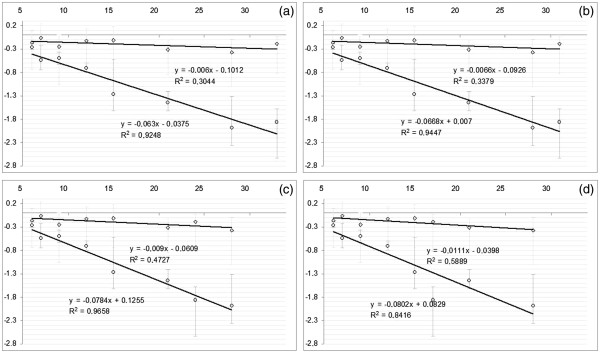
Linear regressions for LEGFrgroup (diamonds) and HEGFrgroup (circles) with y = ln(lnLCRS/lnLCRF) and x = (TS-TF) (days). The higher angular coefficient of HEGFr group line demonstrate a reduction of effective doubling time with respect to LEGFr group (proportionality with the inverse of the effective doubling time). Sub-figures refer to a different onset of accelerated repopulation (a) Tk = 0, (b) Tk = 14, (c) Tk = 21, (d) Tk = 28 days. Error bars represent the 95% confidence intervals.